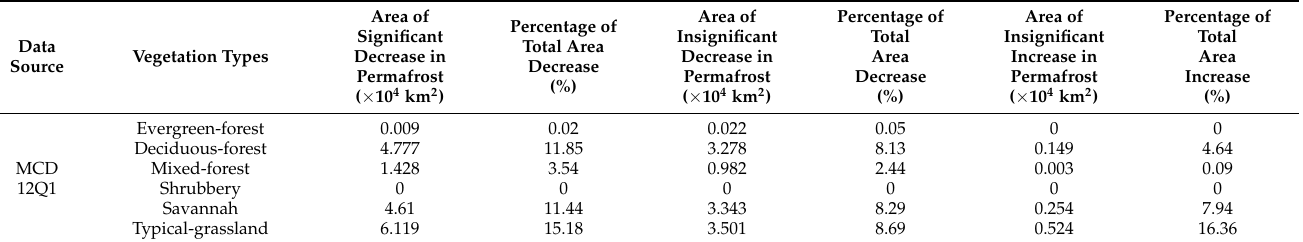
Table 1. The spatial variation characteristics of permafrost in different vegetation cover types (Note: Significance is at the p < 0.05 level. Others is not a vegetation cover type and does not participate in the